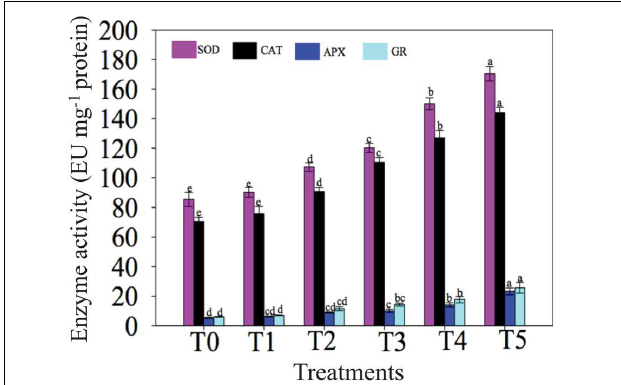
FIGURE 3 | Effects of NO on activities of superoxide dismutase (SOD), catalase (CAT), ascorbate peroxidase (APX), and glutathione reductase (GR) in leaves of chickpea plants under salt stress. Data presented are the means ± SEs ( n = 5). Different letters indicate significant difference ( P ≤ 0.05) among the treatments. T0 (control) = 0 mM NaCl + 0 µ M SNAP; T1 = 0 mM NaCl + 50 µ M SNAP; T2 = 50 mM NaCl + 0 µ M SNAP; T3 = 50 mM NaCl + 50 µ M SNAP; T4 = 100 mM NaCl + 0 µ M SNAP; T5 = 100 mM NaCl + 50 µ M SNAP. EU, enzyme unit.